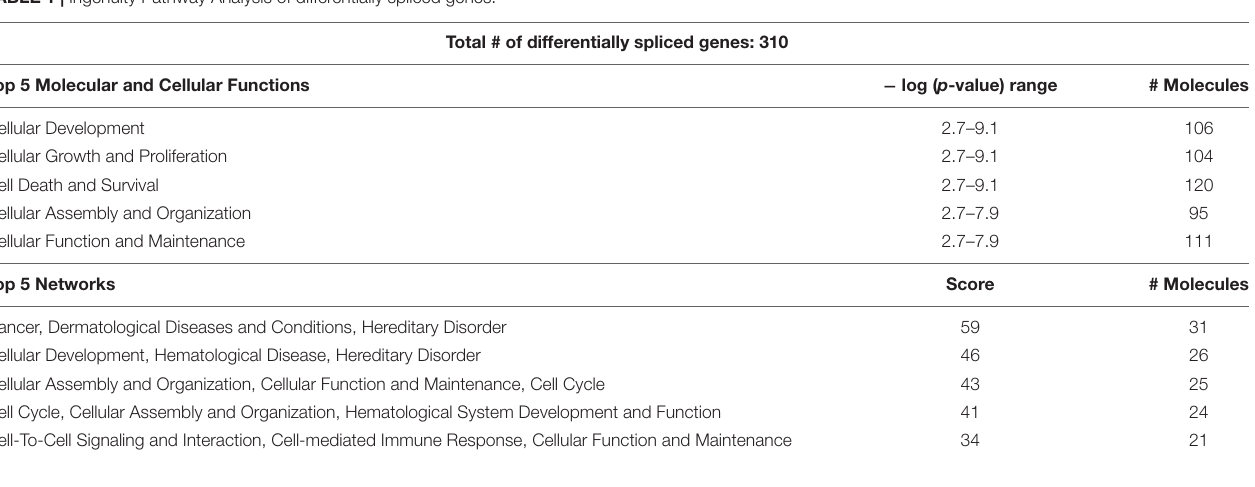
TABLE 1 | Ingenuity Pathway Analysis of differentially spliced